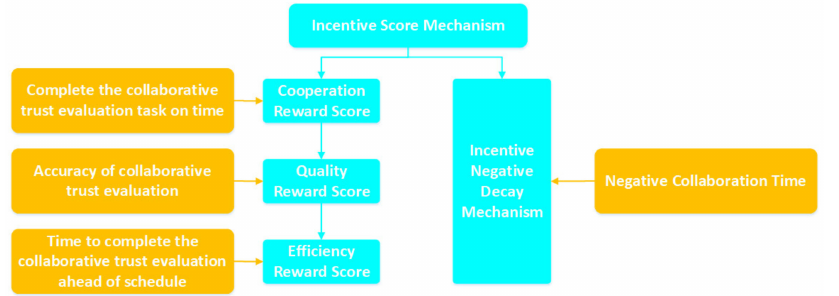
Figure 5. Edge cooperative incentive score